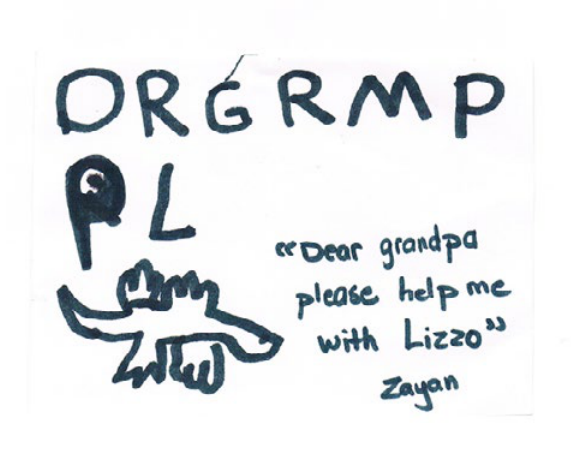
Figure 2: Letter from a five-year-old asking Grandpa to help build a house for the class pet, a lizard named